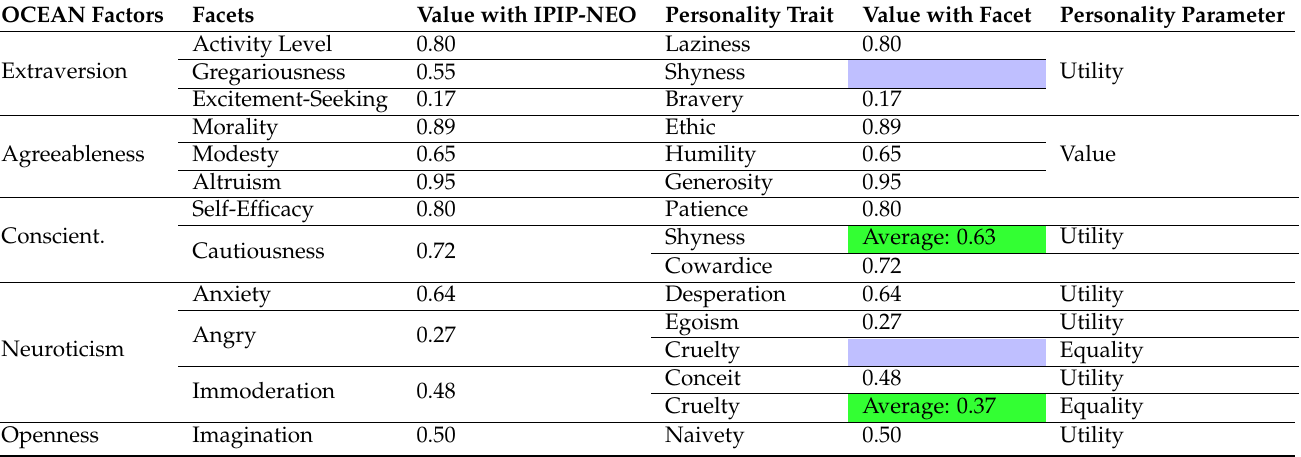
Table 6. Intensification of personality traits through the OCEAN facets [25] and IPIP-NEO question- naire [26].